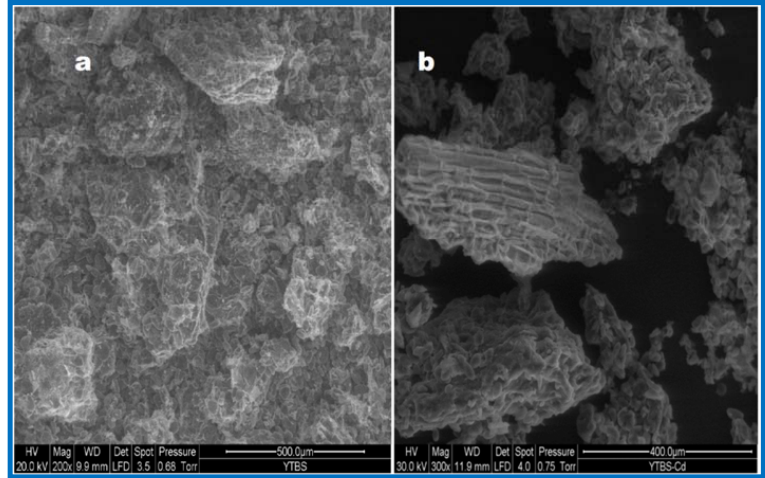
Figure 3. Electron micrograph of YTBS before ( a ) after ( b ) Cd(II) ion adsorption.